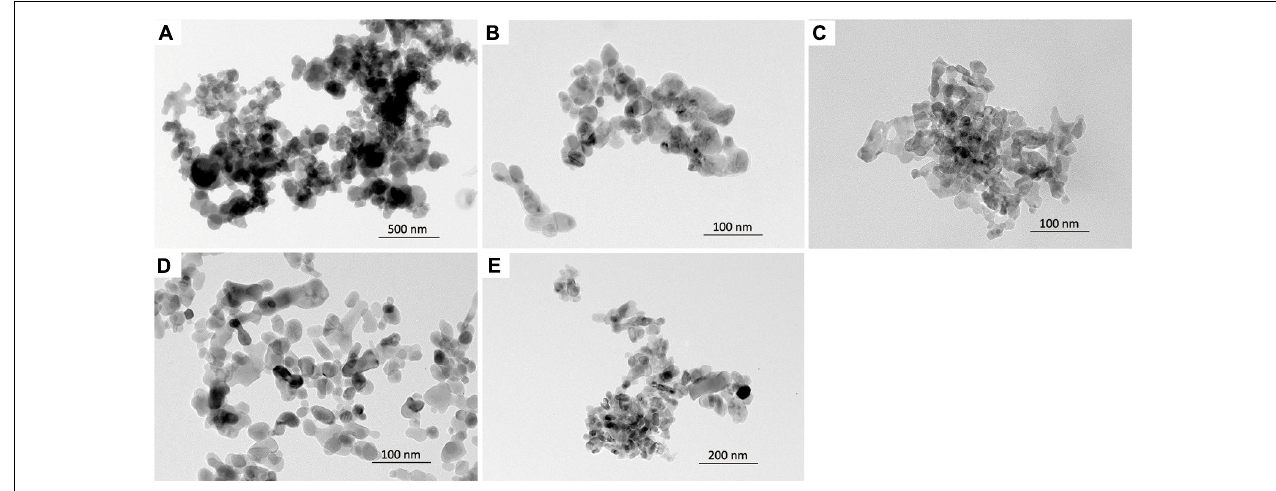
FIGURE 1 | The morphology of NPs observed by a transmission electron microscopy. (A) CoO NP, (B) CuO NP, (C) ZnO NP, (D) Co 3 O 4 NP, and (E) TiO 2 NP.